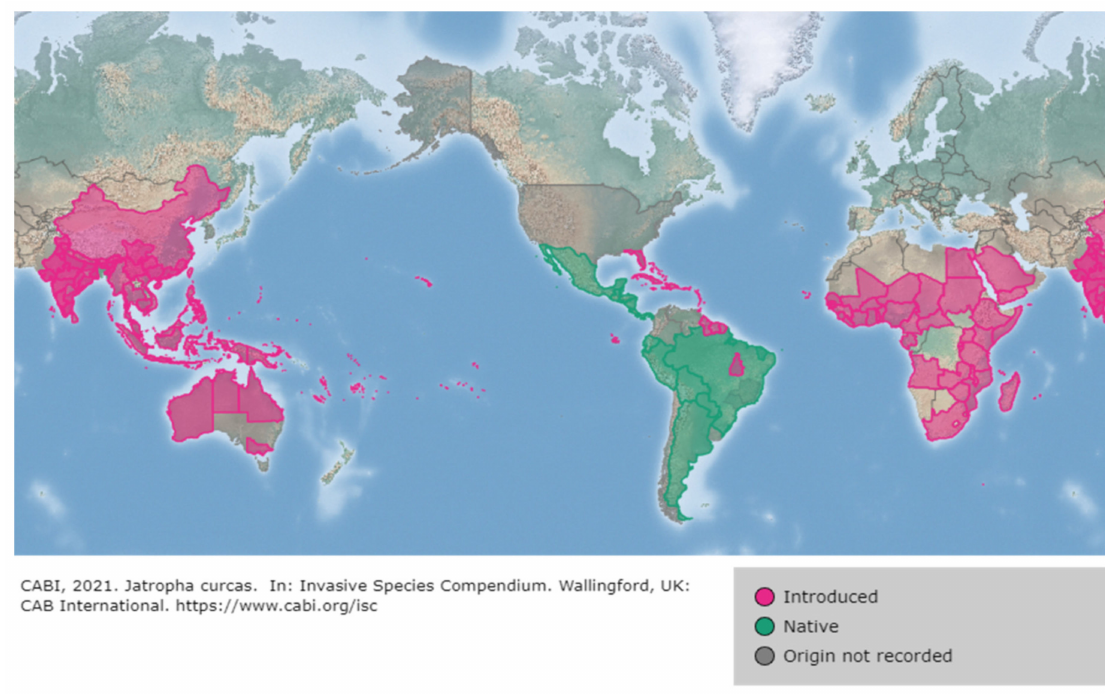
Figure 1. Map showing the distribution of J. curcas across the world. Source: CABI, 2021. https://www.cabi.org/isc (accessed on 25 June